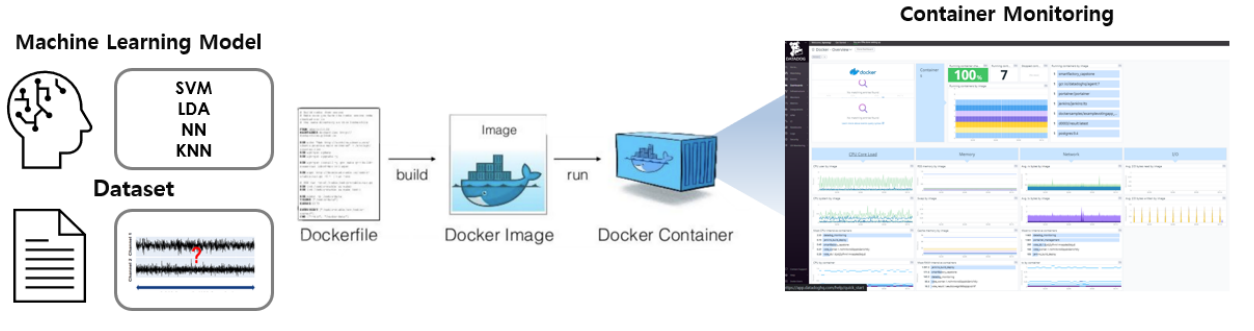
Figure 11. Machine-learning model is packaged as a Docker image, and run as a Docker